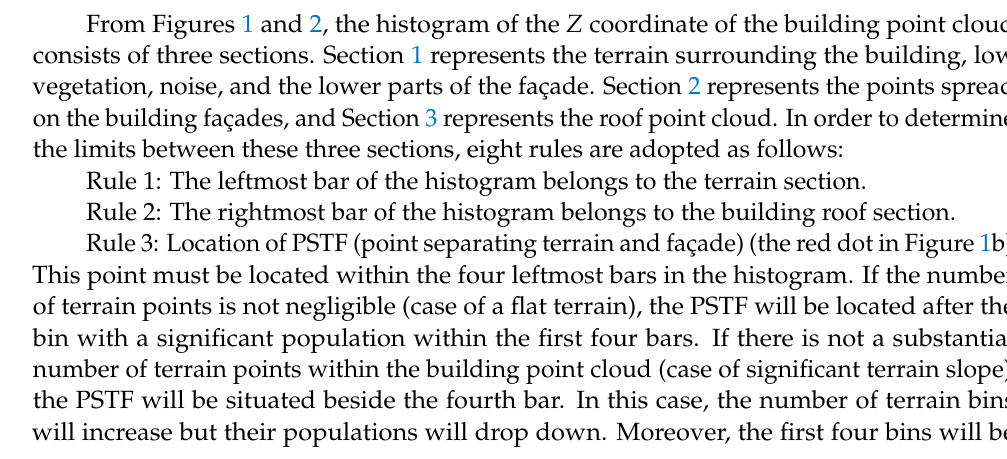
Figure 1. ( a , d ) Building point clouds in Vaihingen and Hermanni datasets; ( b , e ) histograms of Z coordinate of building point clouds consecutively of the last two buildings; ( c , f ) final results of building point clouds’ filtering; The red dot in ( b , e ) is the PSTF; “1,2,3” in circles in ( b , e ) are building section